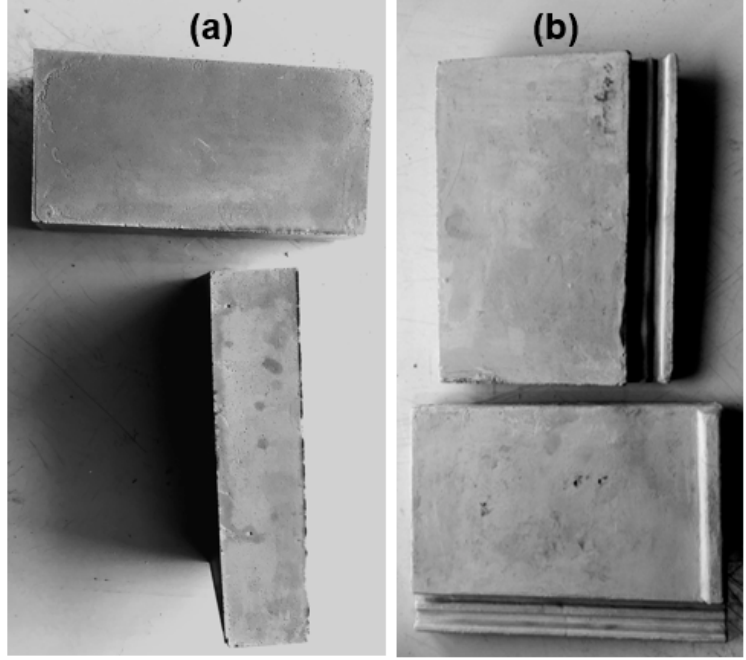
Figure 5. Fly ash-based products, ( a ) paving bricks, and ( b ) roof tiles .